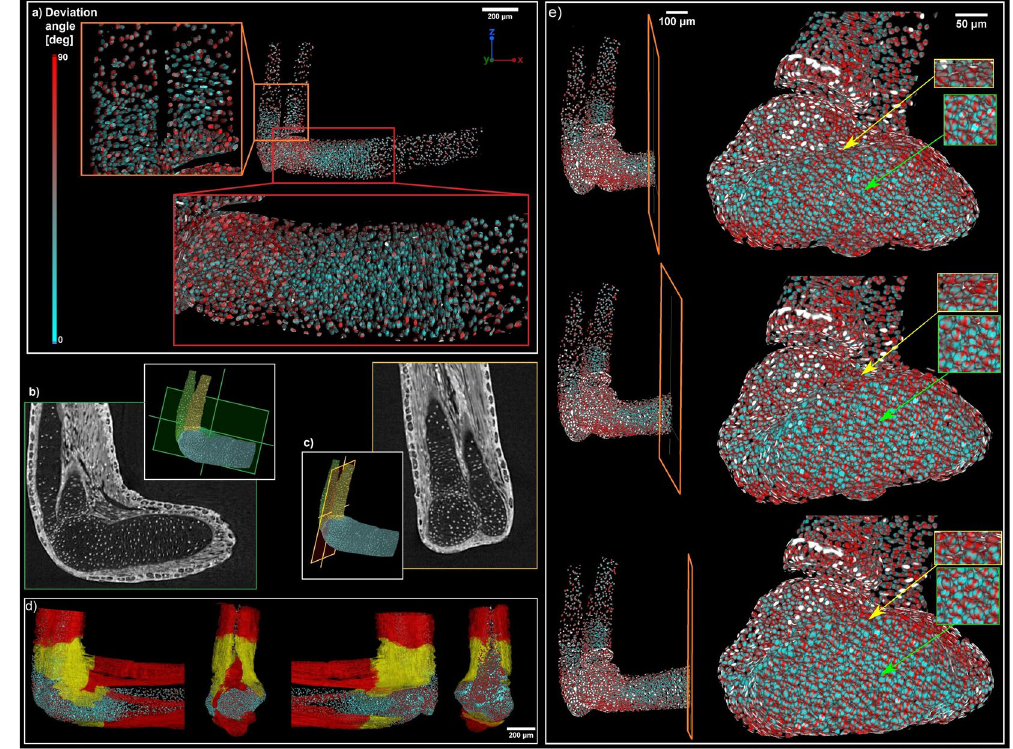
Figure 7. ( a ) Polarization of the cells inside cartilage. There are polarized zones between diaphysis and epiphysis for all cartilaginous elements: ulna , radius and humerus . Deviation angle 0° for ulna and radius was set to the plane x , y and for humerus was set to the plane y , z; ( b , c ) Corresponding tomographic slices verifying the computation of polarization; ( d ) Muscle attachment points in correlation with cell polarization; ( e ) Detail of orientation of the cells: Superficial chondrocytes near surface (yellow arrow) are aligned with the developing surface of the cartilage in the contrary of chondrocytes in the middle of the cartilage (green